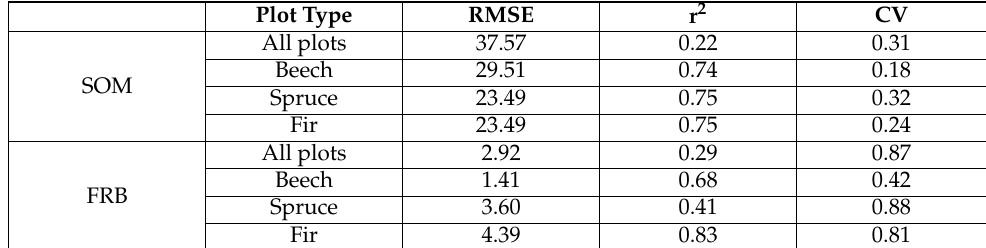
Table 9. Evaluation of model performance for tree stands’ biomass based on RMSE (root mean square error), r 2 (coefficient of determination) and CV (coefficient of